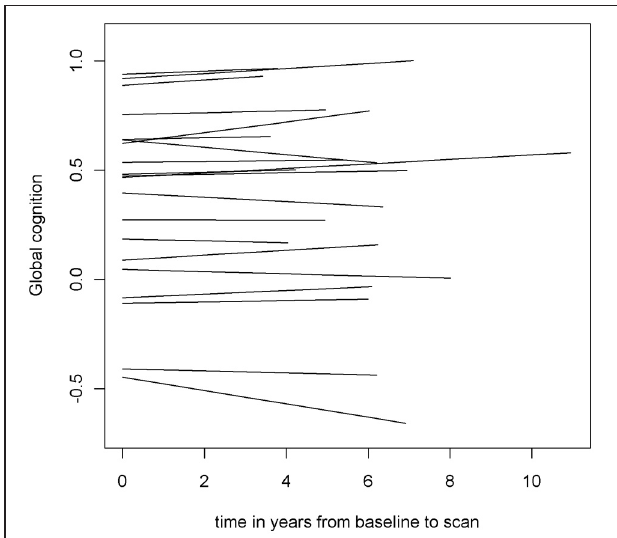
FIGURE 1 | Predicted linear decline in global cognition for a randomly-selected sample of 20 persons.